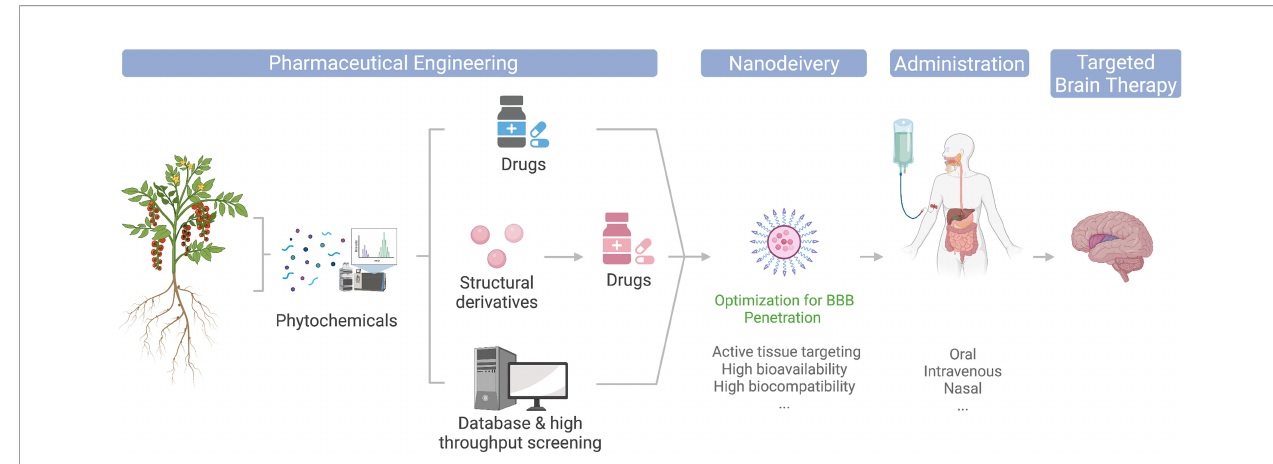
FIGURE 1 | Illustration of phytochemicals undergoing different engineering approaches toward clinical and market-ready available drugs; nanodelivery platforms could potentially optimize their application for brain disease